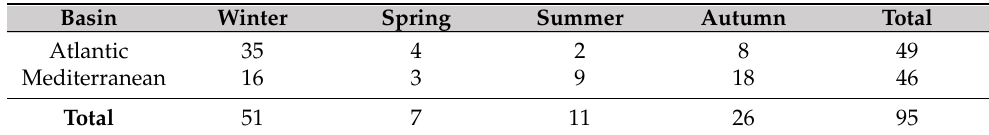
Table 3. Distribution, by basin, of the number of extreme weather events recorded for each season of the year.